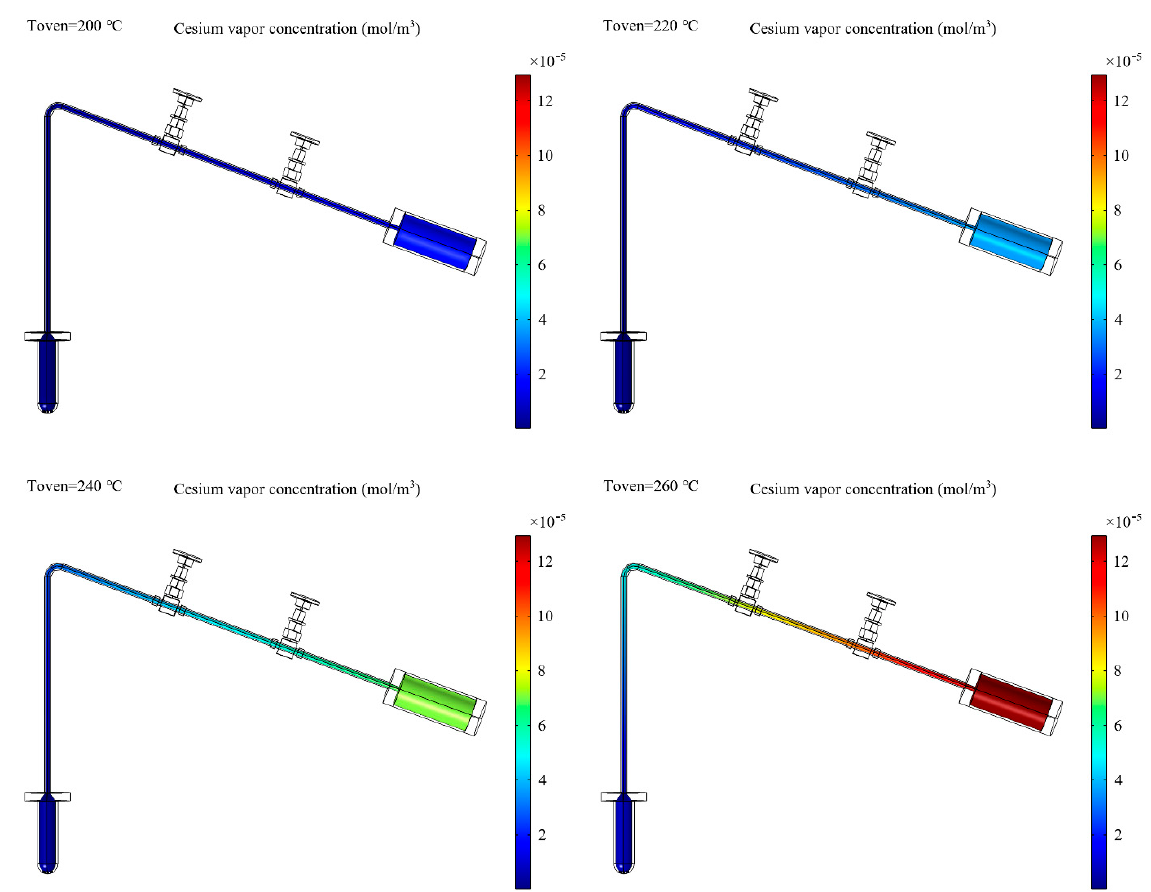
Figure 11. The simulation results of the vapor concentration at different temperature. The total Cs flux is calculated by Equation (2). Here, n is concentration of Cs vapor (mol/m 3 ), which is simulated in Figure 11. The Cs vapor concentration of nozzle is used as the input of Equation (3). N A is Avogadro’s constant. m is the mass of a Cs atom. A is the nozzle area (m 2 ). v is the average particle velocity, which is calculated by Equation (3) [11]: